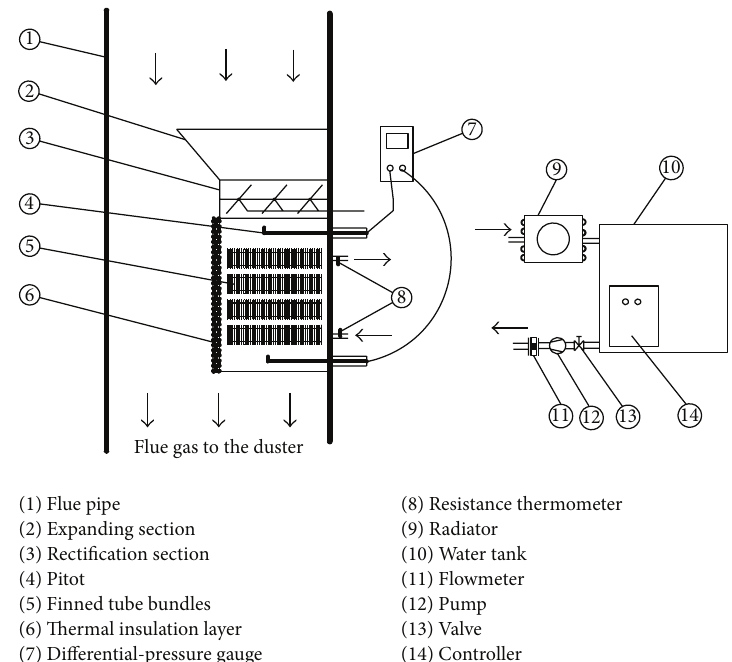
Figure 1: Experimental system